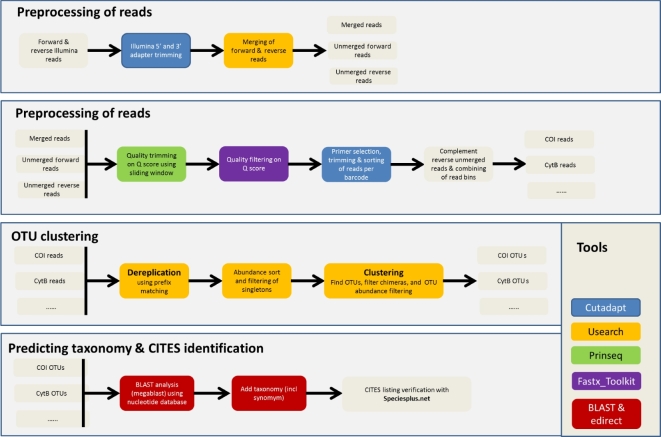
Schematic representation of the CITESspeciesDetect pipeline.